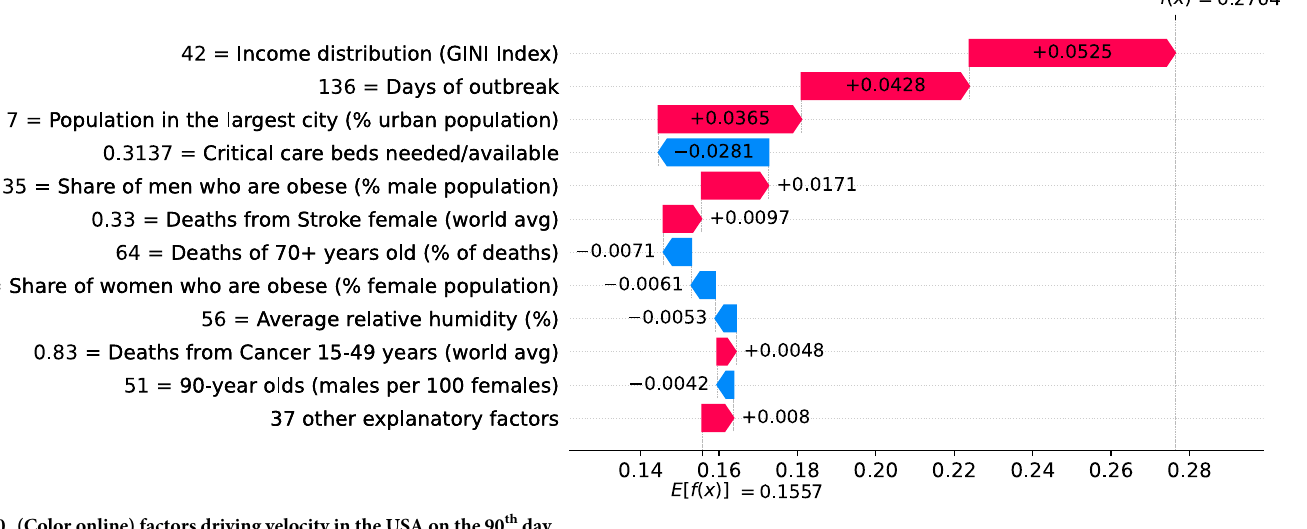
Fig 40. (Color online) factors driving velocity in the USA on the 90 th